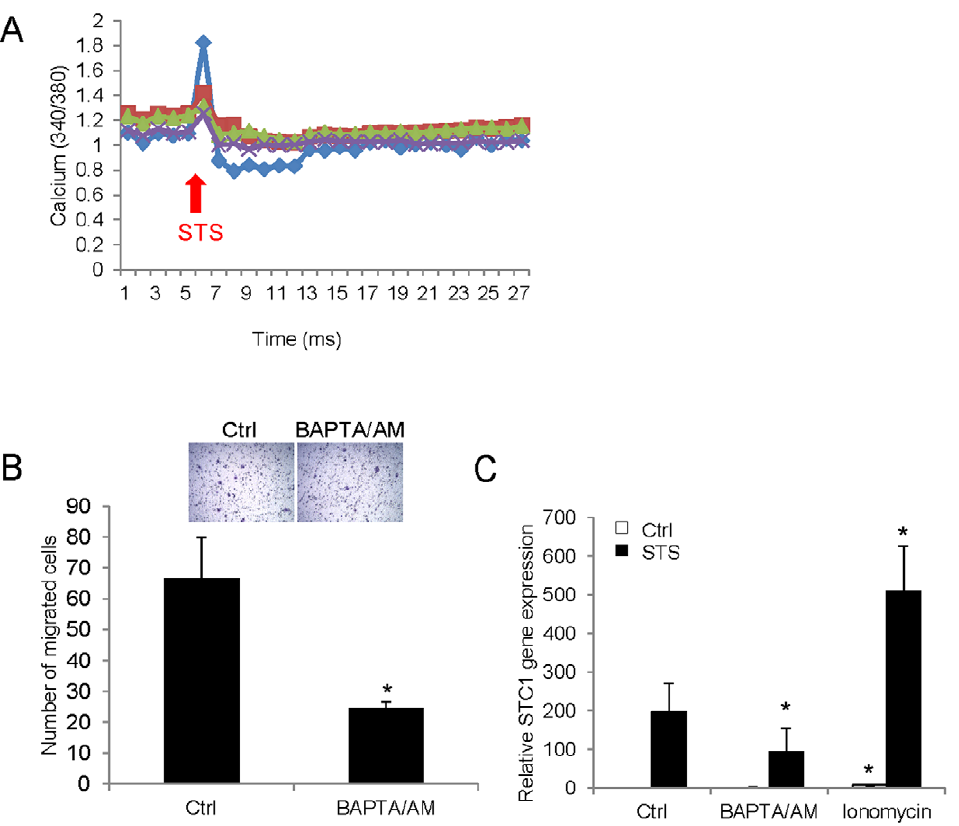
Figure 2. STS-induced migration is mediated by intracellular Ca 2 + influx. (A) STS treatment increased [Ca 2 + ]i as measured using Ca 2 + detection dye, Fura 2-AM. (B) The number of migrated cells was significantly reduced by 10 m M BAPTA/AM at 24 h (vs Ctrl) and the cell images were captured under 100x magnification ( top ). (C) STS-induced STC1 mRNA was further induced by 1 m M ionomycin but was downregulated by 10 m M BAPTA/AM at 24 h of the cotreatments. Asterisks (*) denote p , 0.05 as compared to the